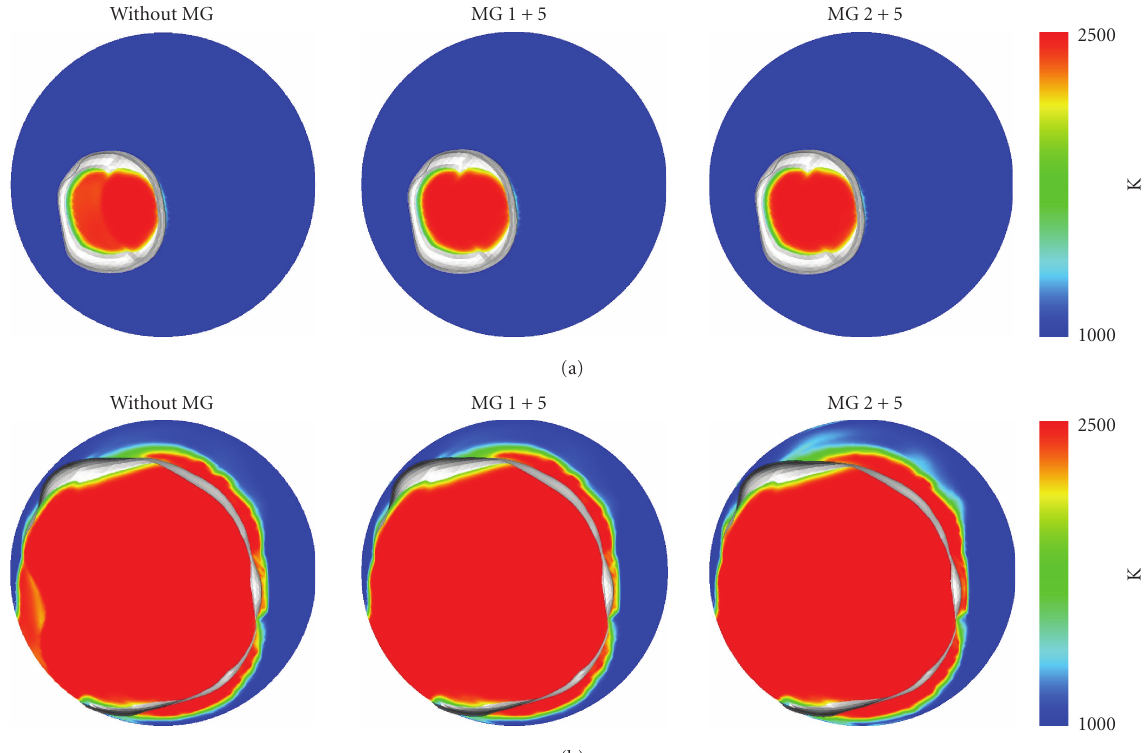
Figure 11: Iso-surface of flame front and temperature distribution at CA = 3 (a) and 18 (b)deg ATDC simulated using two-zone MG model with di ff erent searching levels and skipping high-temperature cells ( T > 800K) in the unburned region.